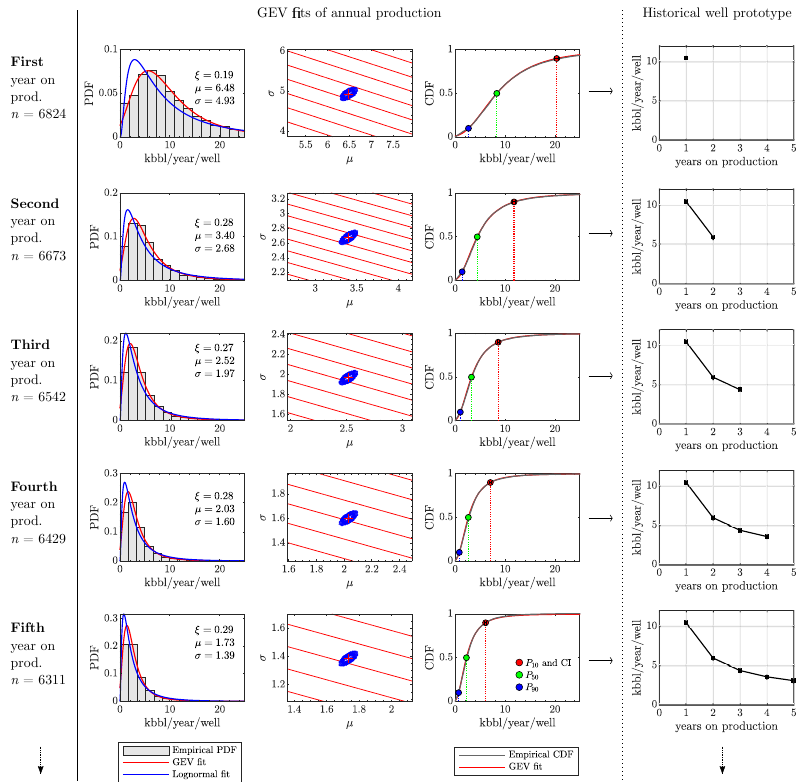
Figure 7. Procedure of arriving at a historical well prototype using GEV statistics. (Example: Midland Basin—Leonardian [2000–2009]). Each row shows different sampling of annual production after the first, second, ..., n -th year on production. The first column is the probability density function (PDF) of annual production fitted with lognormal distribution (blue) and GEV distribution (red). The corresponding ξ , µ , and σ are the fitting parameters for the GEV distribution. The second column shows the maximum likelihood estimate, 95% confidence interval (CI) for µ and σ . The third column displays the cumulative distribution function (CDF), including the lower bound, P 90 , median, P 50 , and upper bound, P 10 , with its confidence interval. The last column shows the resulting historical well prototype, which is constructed by connecting the expected GEV values (means) of each